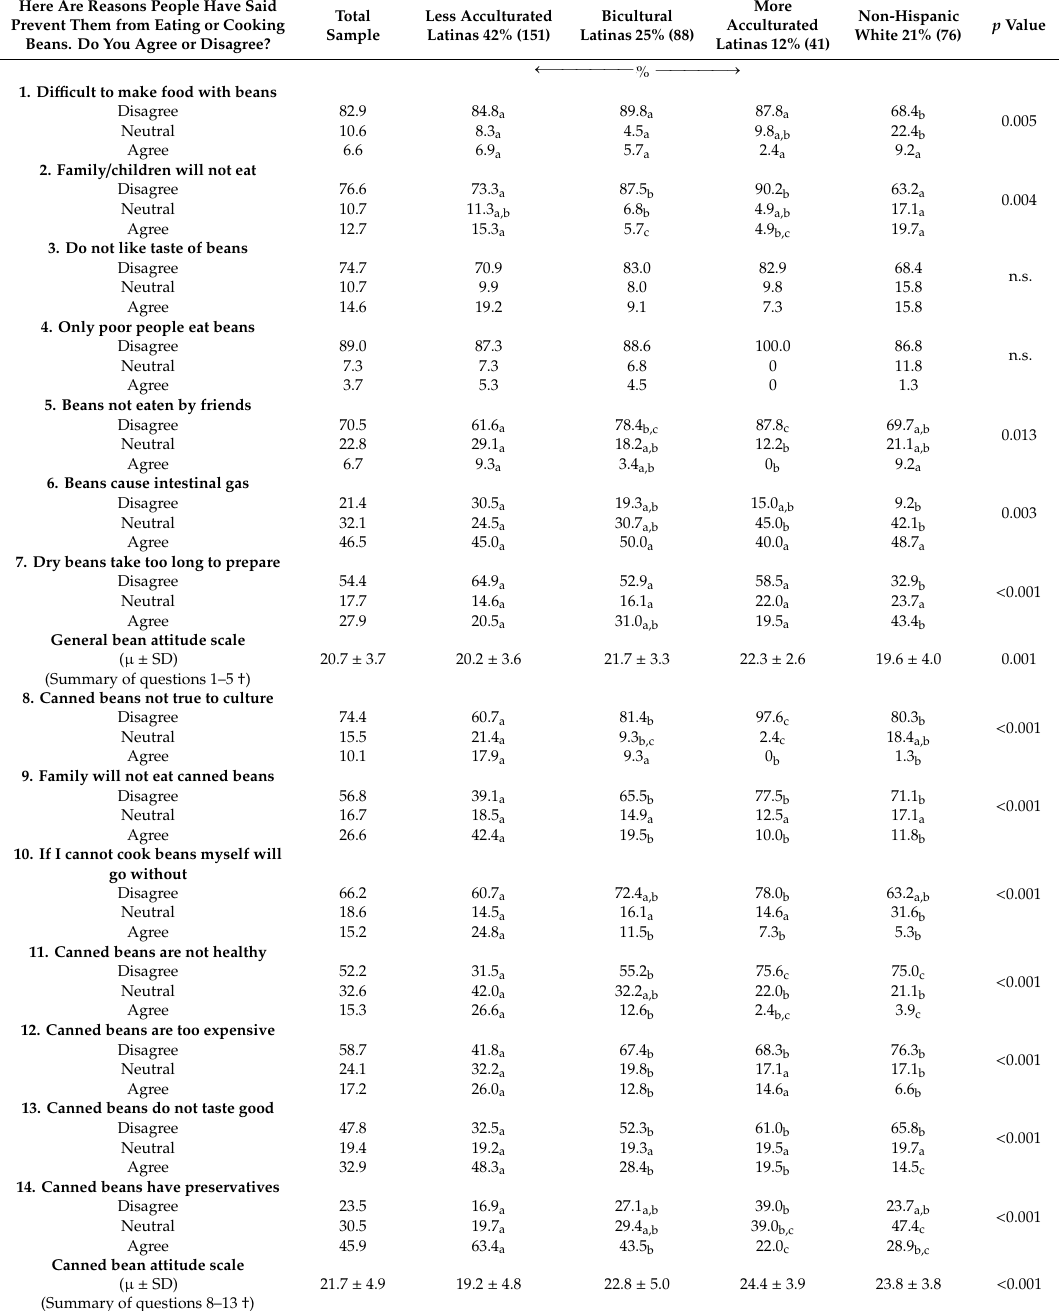
Table 3. Beliefs and attitude scores with respect to general and canned beans among low-income Arizona women by Bidimensional Acculturation Scale category ( N = 356).